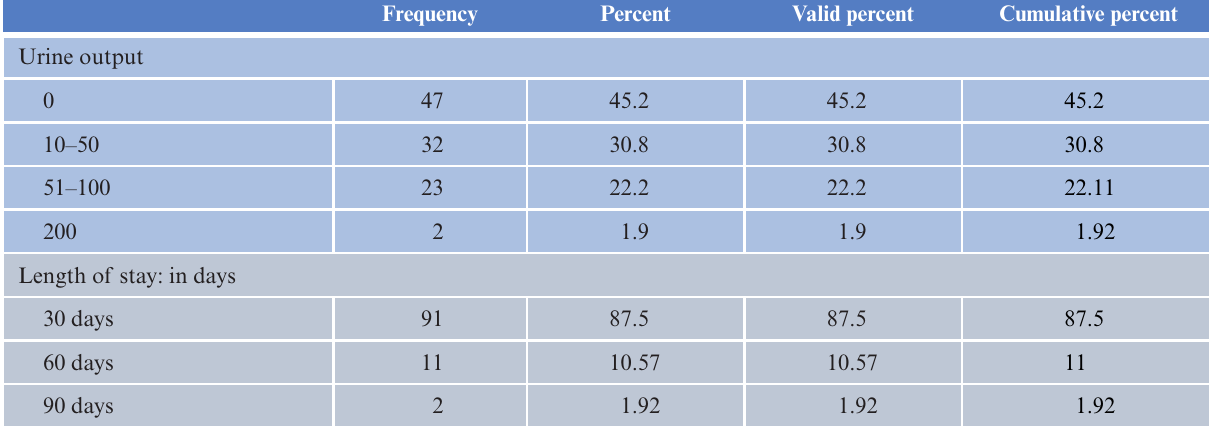
Table 2: Showing urine ouput and length of stay of patients.